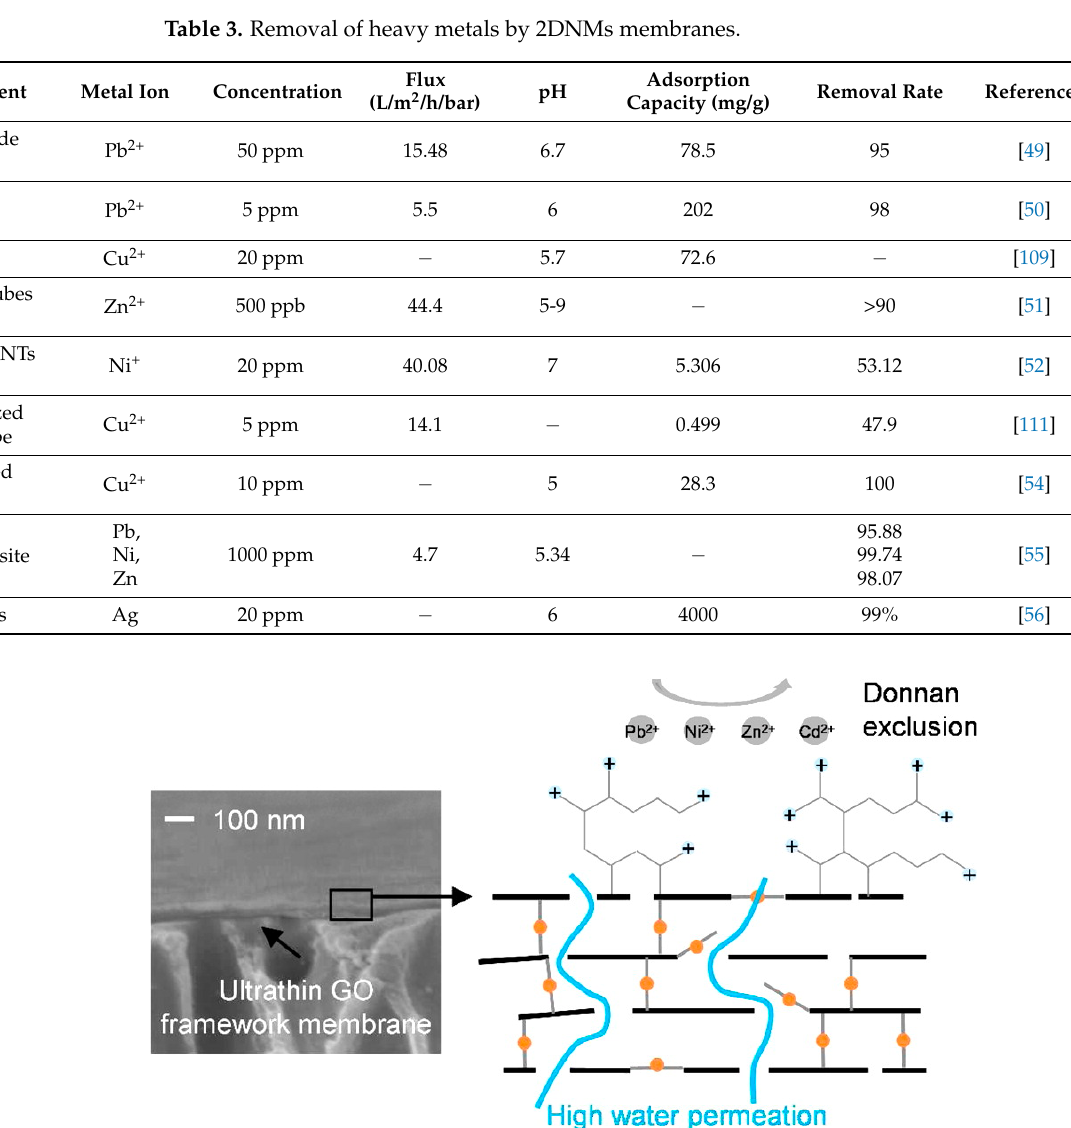
Figure 5. An illustration of heavy metal rejection in graphene oxide framework membrane (repro- duced from [110] with permission from the American Chemical Society).